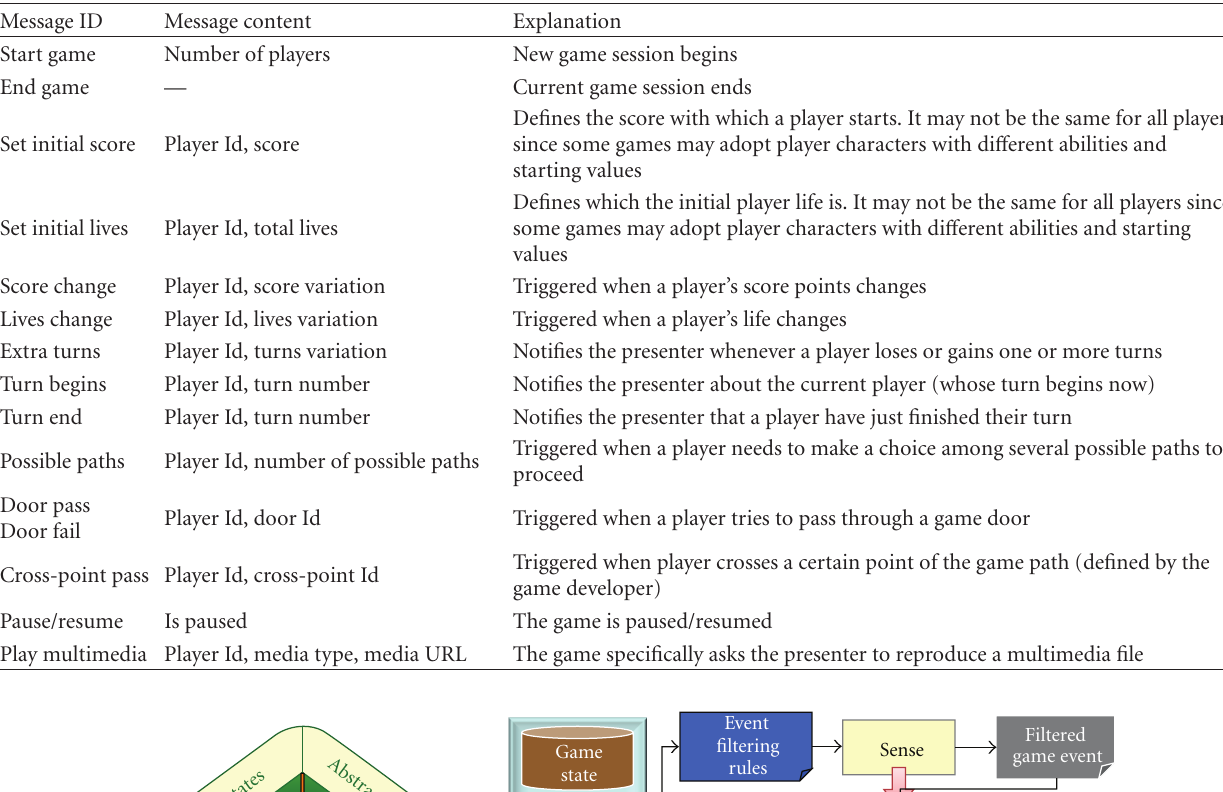
Table 1: The most common messages of the communication protocol (API) for tabletop board games.